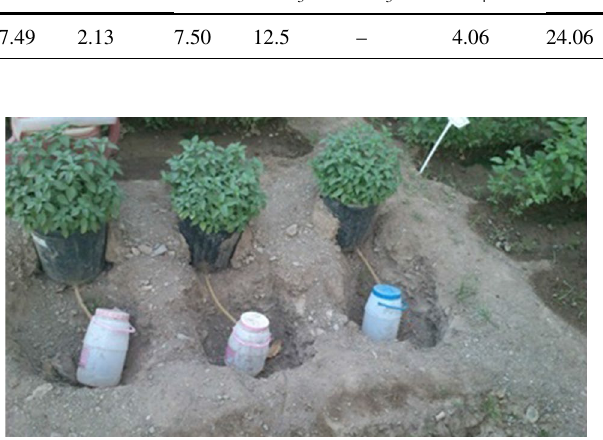
Table 4 Chemical factors of the field's soil pH EC Anion (meq/lit) The sum of anions (ds/m)